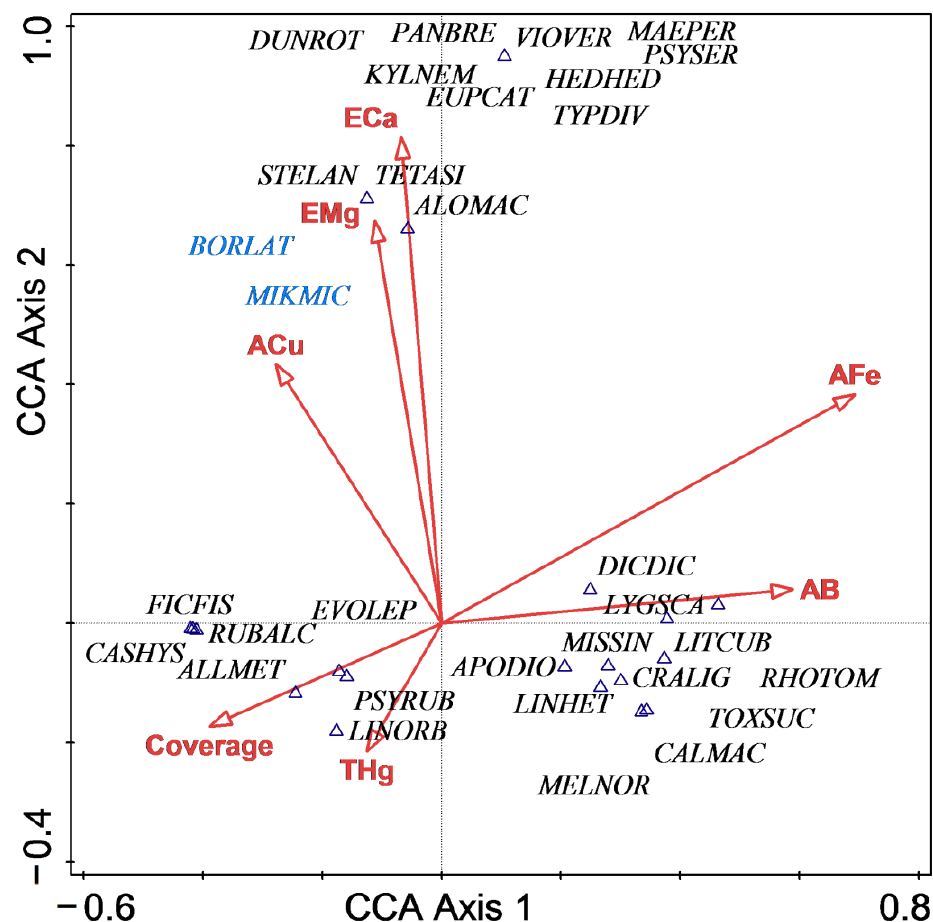
Figure 5. Ordination biplot showing the first two-axis results from canonical correspondence analysis (CCA) of both native (black color) and invasive (blue color) species in the understory of the resident communities. The top 32 species were selected from the analysis. Species codes: DUNROT = Dunbaria rotundifolia ; PANBRE = Panicum brevifolium ; KYLNEM = Kyllinga nemoralis ; EUPCAT = Eupatorium catarium ; TETASI = Tetracera asiatica ; ALOMAC = Alocasia macrorrhiza ; STELAN = Sterculia lanceolata ; BORLAT = Borreria latifolia ; MIKMIC = Mikania micrantha ; VIOVER = Viola verecunda ; MAEPER = Maesa perlarius ; HEDHED = Hedyotis hedyotidea ; TYPDIV = Typhonium divaricatum (L.) Decne. ; PSYSER = Psychotria serpens ; FICFIS = Ficus fistulosa ; EVOLEP = Evodia lepta ; RUBALC = Rubus alceaefolius ; CASHYS = Castanopsis hystrix ; ALLMET = Allantodia metteniana ; PSYRUB = Psychotria rubra ; LINORB = Lindsaea orbiculata ; DICDIC = Dicranopteris dichotoma ; LYGSCA = Lygodium scandens ; MISSIN = Miscanthus sinensis ; LITCUB = Litsea cubeba ; APODIO = Aporosa dioica ; CRALIG = Cratoxylum ligustrinum ;